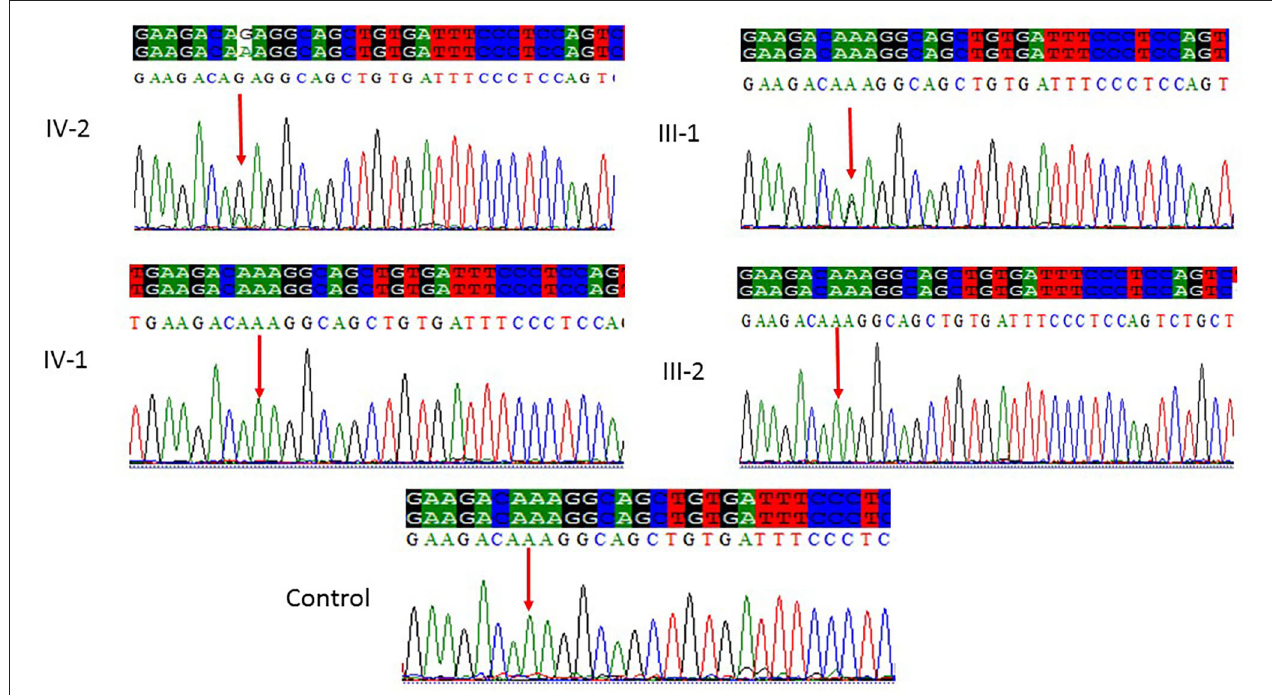
FIGURE 4 | Sanger sequencing chromatograms showing a missense mutation where c.5623A > G leads to a change in protein p.Lys1875Glu in exon 18 of the ASPM gene in family 3. Proband IV-2 showed replacement of A > G as compared with the normal control, while one parent (III-1) is heterozygous and III-2 is homozygous, whereas the normal brother IV-1 was homozygous at this position. Panel showing the sequencing of the affected member as well as the normal brother and parents; the arrow is pointing at the site of